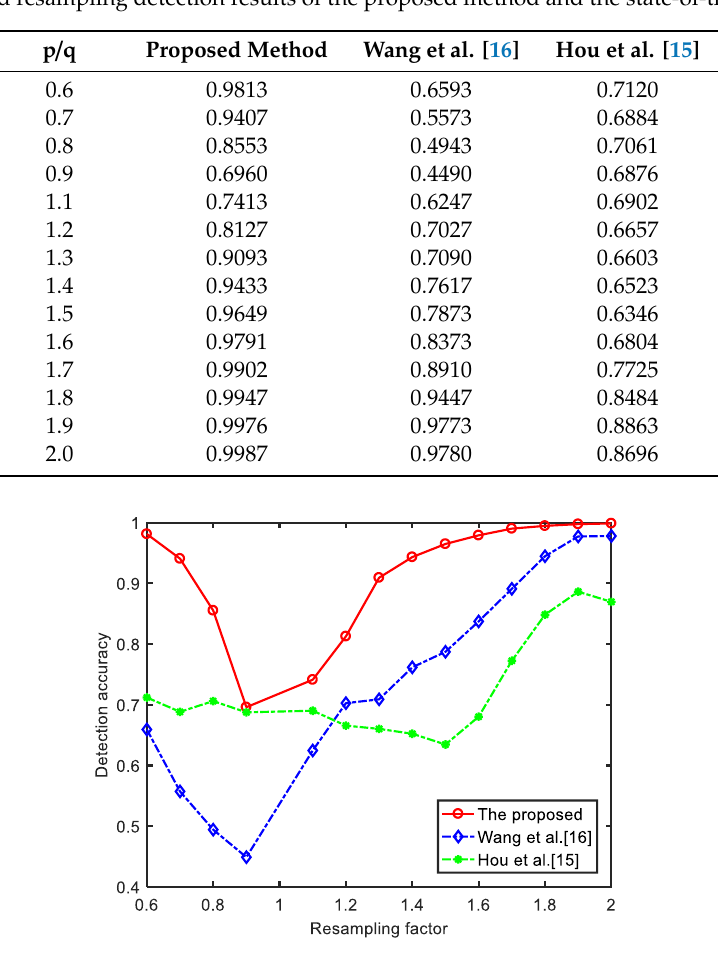
Table 4. Mixed resampling detection results of the proposed method and the state-of-the art studies.